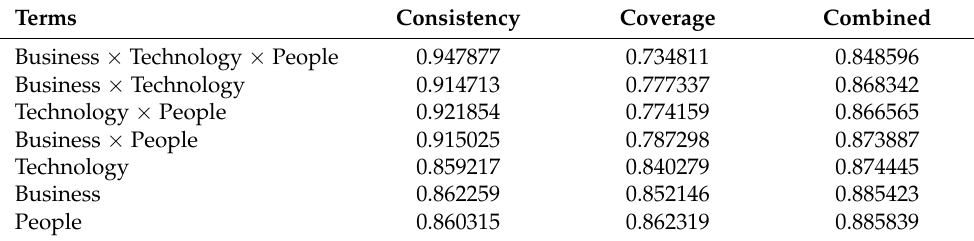
Table 4. Sub/super